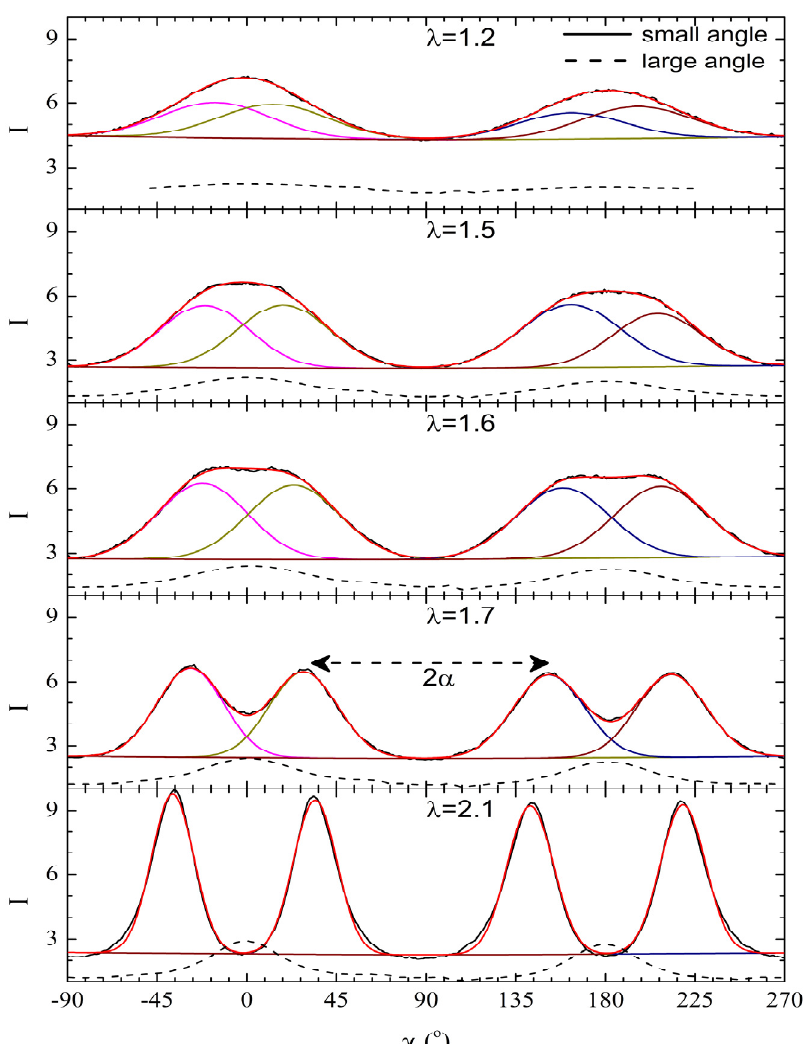
Figure 10. LCE1: Azimuthal intensity I (arbitrary units) profiles ( χ -scans) for SAXS and WAXS peaks in Figure 9. The red curves are the sum of two Gaussian curves used to determine the peak positions. At λ = 1.5, the SAXS reflections becomes flat at the top due to superposition of unresolved peaks out of which four peaks start to eventually emerge at λ = 1.6, clearly leading to four peaks at λ = 1.7. The WAXS peaks continue to gradually sharpen with increasing